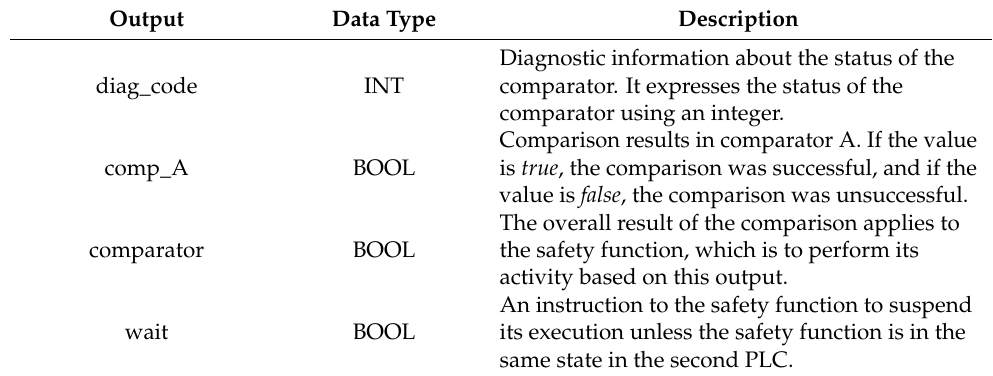
Table 4. Comparator output